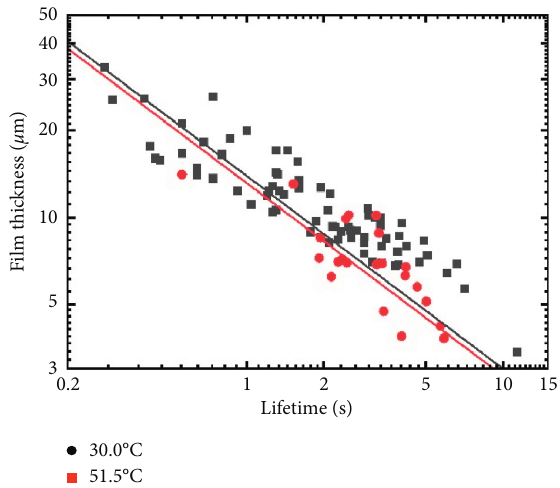
Figure 16: Correspondence of the bubble cap film thickness lifetime at different gas-phase